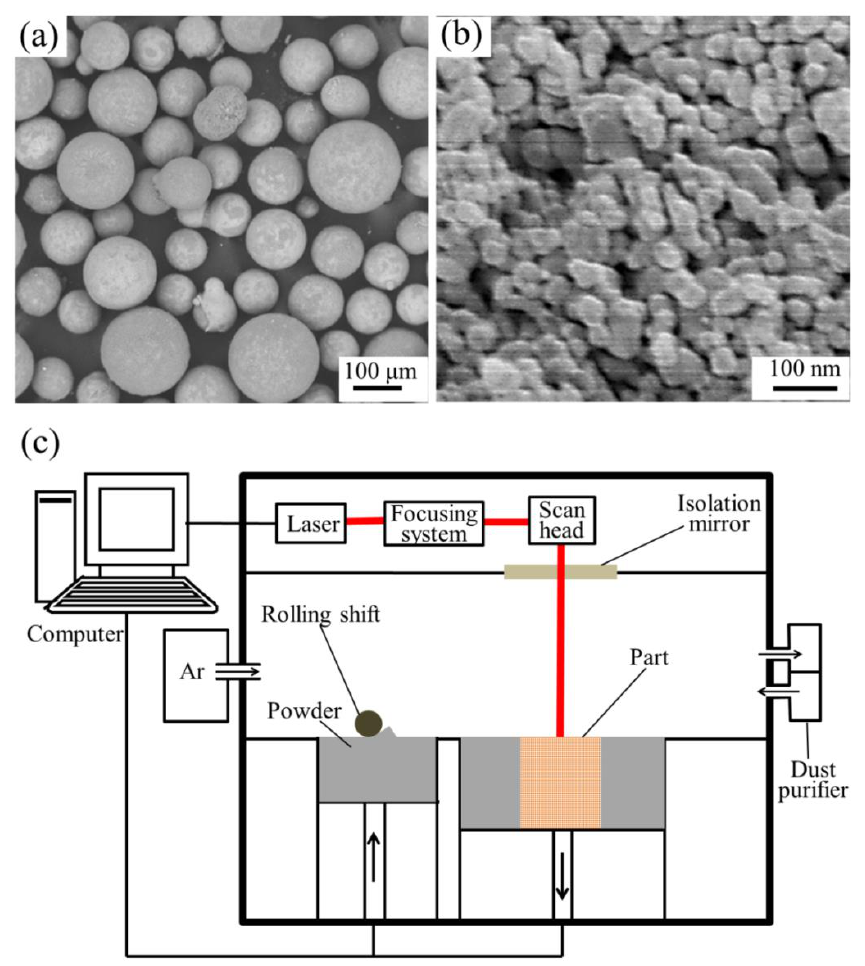
Figure 1. Morphology of ( a ) ZK60 alloy powder and ( b ) ND powder; ( c ) the schematic diagram of SLM process.